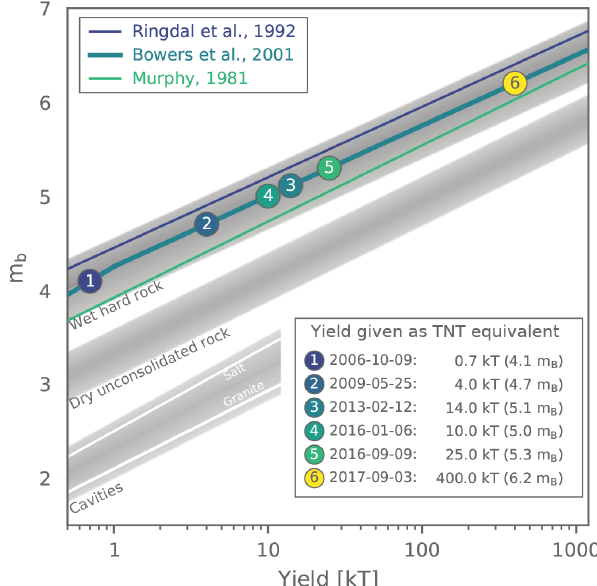
Figure 10. Magnitude–yield relation curves for different geological settings. Numbered circles indicate the six North Korean nuclear tests. Gray background shading represents lower and upper bound- ary literature values for the different